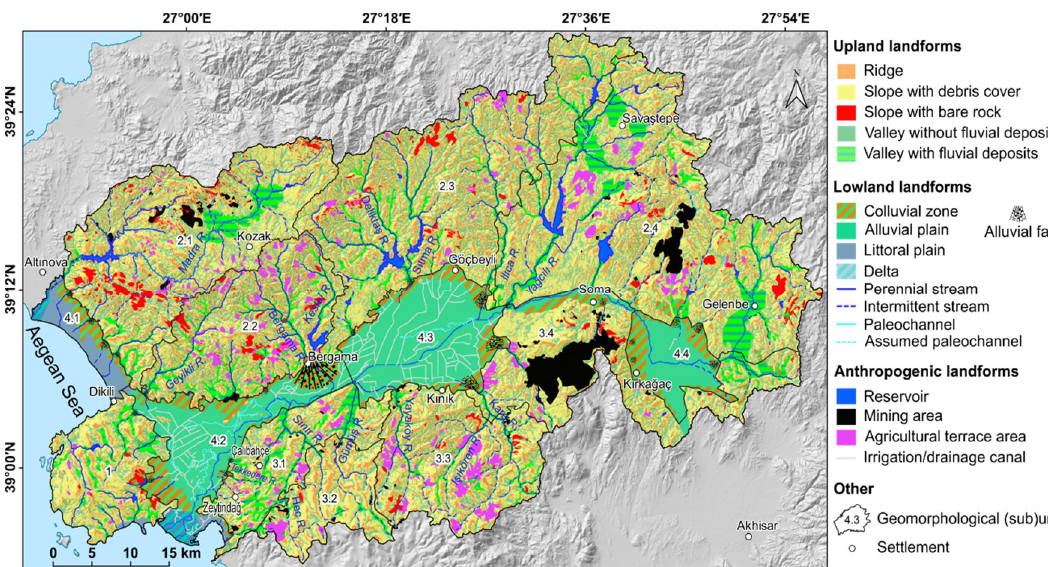
Figure 4. Geomorphological map of the Bakırçay and Madra River catchments according to the classification rules in Table S1 [83]. Note that paleochannels and terraces are not exhaustive. Geomorphological (sub)units are indicated by numbers; for territorial extent of the geomorphological (sub)units see Figure 1C.